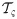
Influence of the γ-modulation on spatial learning in cell assembly network with input integrator readout neurons: clique complexes.A: The dependence of the number of triple connections in the clique coactivity complex Tς is similar to the dependence of the number of 2D simplexes in the simplicial coactivity complex. As the integration window narrows (same range of w’s as on Fig 3), the number of triple connection cliques drops. Cooling down the assemblies produces no significant effect at large integration windows, but does increase the number of triple connections for small w’s (by about 25% for w ≈ Tγ). B: The total number of topological loops observed in the clique coactivity complex Tς is reduced with cooling for small w’s, in a way similar to the case of the coincidence detection (Čech) coactivity complex. At the γ-timescale, w ≈ Tγ, the tendency of the shrinking w’s to cause the clique complex to form large numbers of topological loops is nearly compensated by cooling down Tς: the number of cold loops (β = 2) in Tς is about 50% of the number hot loops (β = 0). Note that despite similar qualitative behaviors, the scales of Nl1σ, and Nl1ς are different: the clique complex produces fewer spurious loops than the simplicial complex. C: Learning times grow as a function of w; however, for the clique complex they remain finite even for w ≈ Tγ. The more tightly clustered the clique complex is around the γ troughs, the more rapidly it learns, especially for small w.